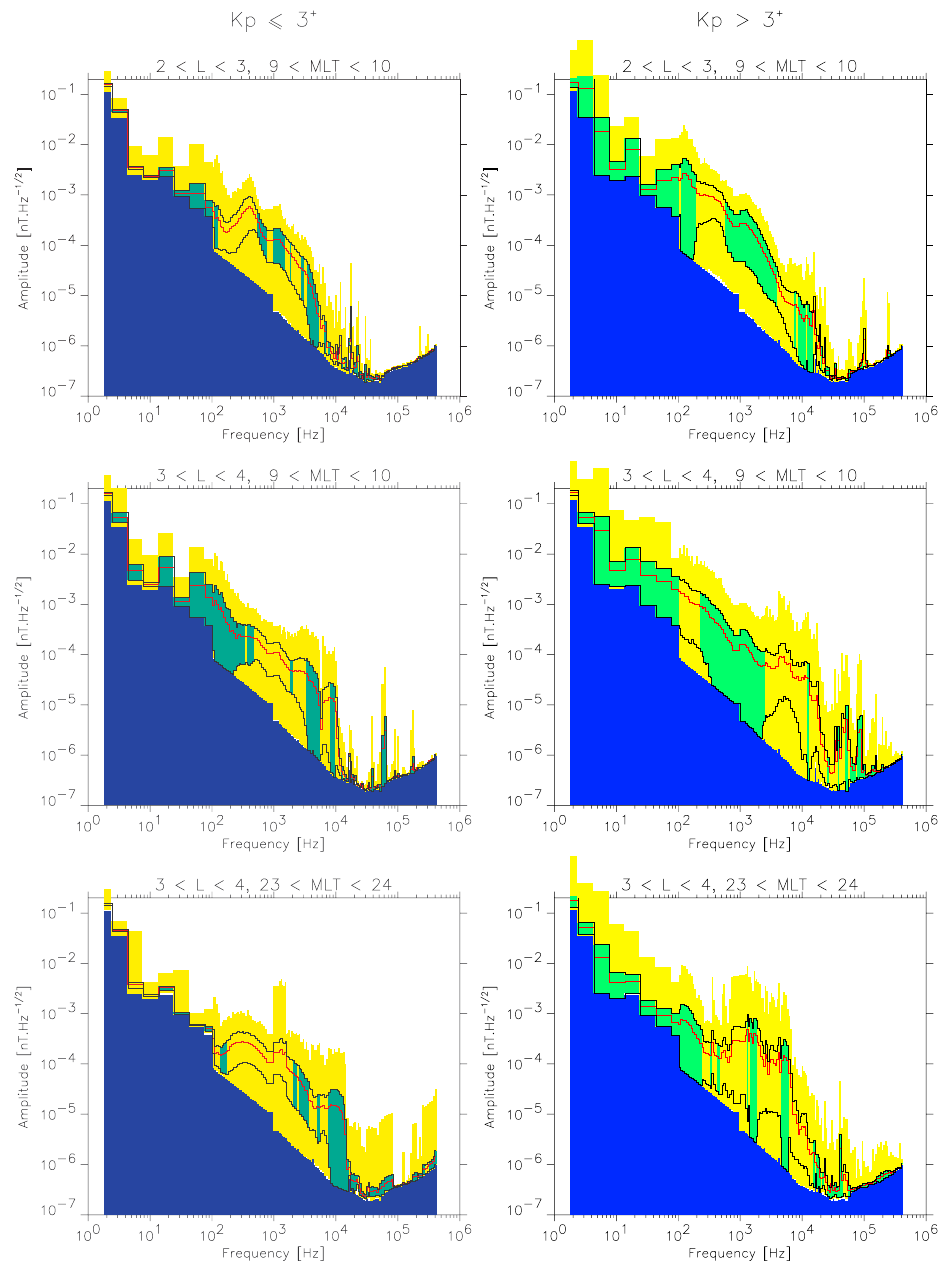
Fig. 3. Averaged amplitude spectra (red lines) in various geophysical conditions with: the instrumental noise level (blue bars), the Gaussian confidence intervals (upper and lower black lines), the intervals in which the Gaussian confidence intervals make sense (green bars) and the extreme values recorded during the spacecraft mission (yellow